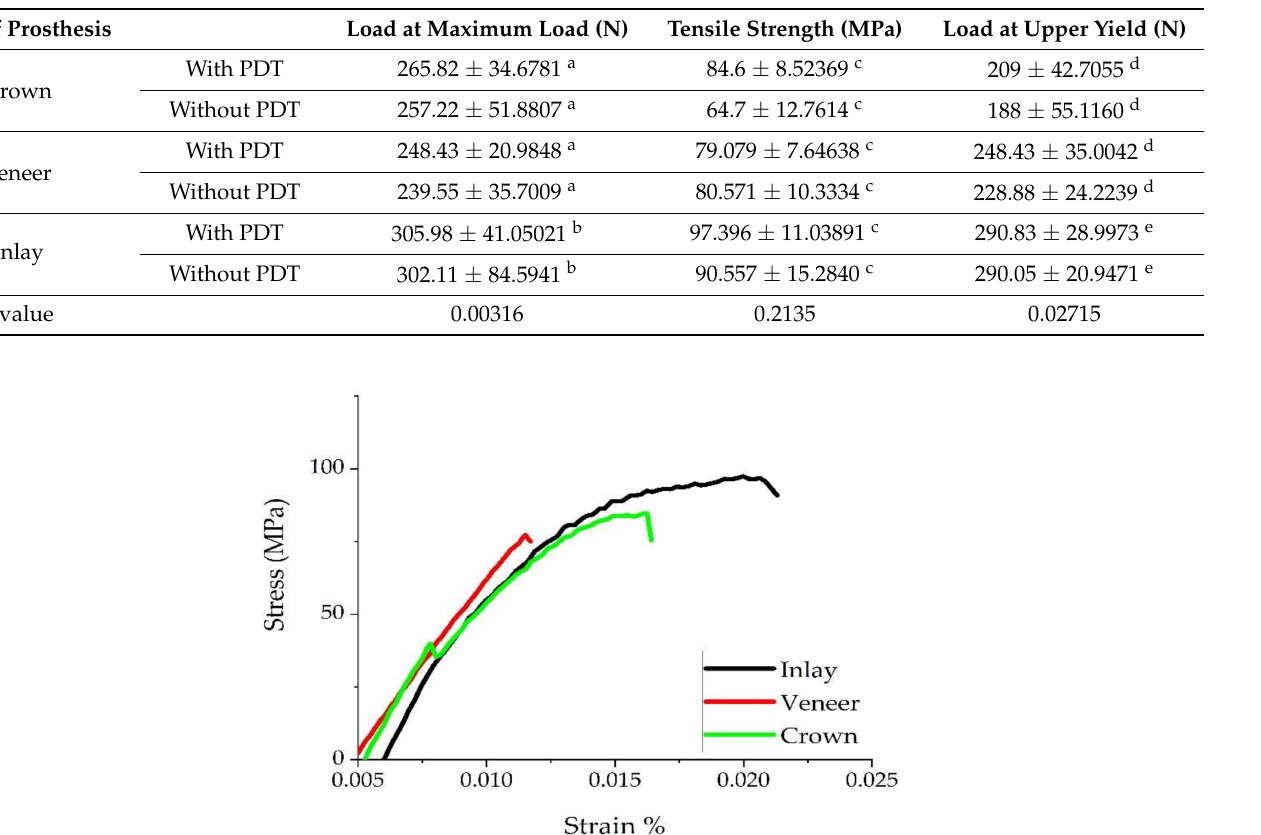
Figure 4. Comparison of the tensile strength highest values from each examined group when PDT was used.